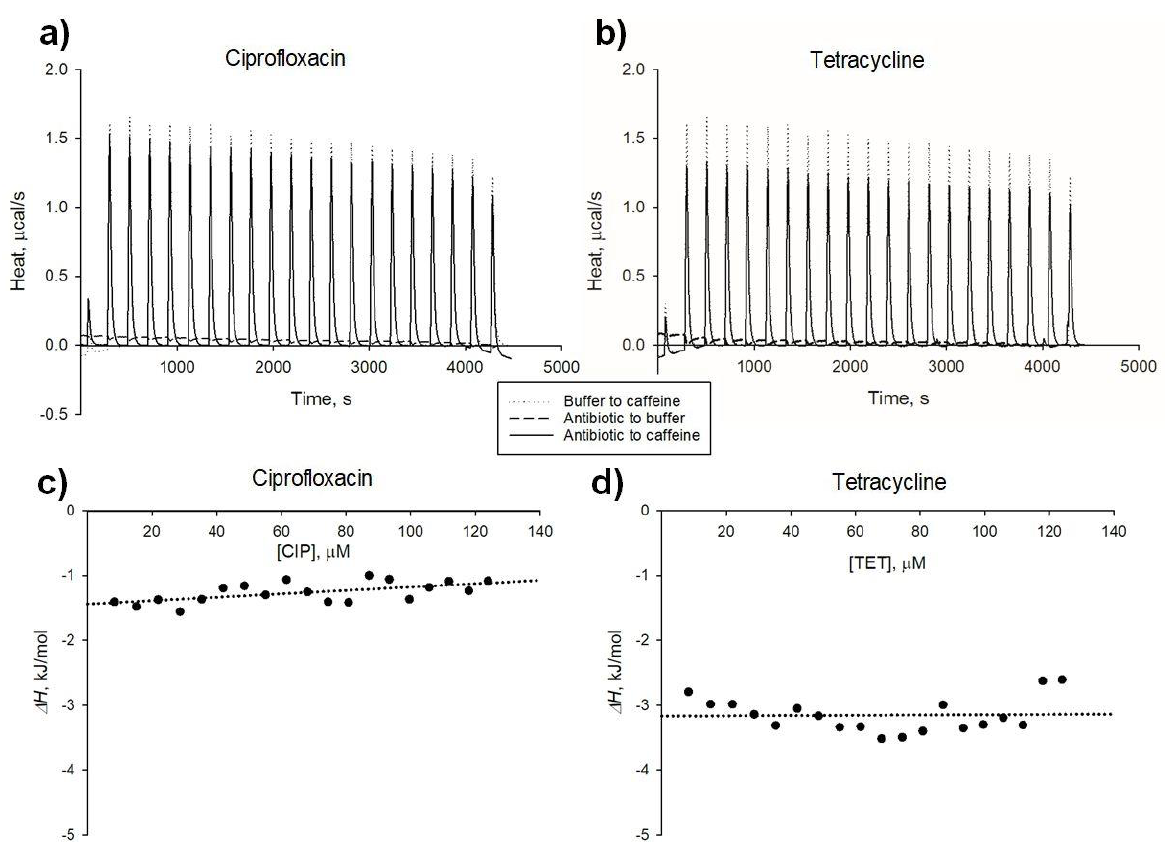
Figure 4. Thermal effects of antibiotic-caffeine complex formation—analysis with isothermal titration calorimetry. ( a,b ), thermograms for analysis of ciprofloxacin-caffeine ( a ) and tetracycline-caffeine ( b ) interactions; solid line, titration of caffeine with antibiotic; dotted line, titration of caffeine with buffer; dashed line, titration of buffer with antibiotic; ( c,d ), determination of enthalpy change (Δ H ) values for ciprofloxacin-caffeine ( c ) and tetracycline-caffeine ( d ) interactions. Points correspond to net heat of antibiotic-xanthine interaction (corrected for heats of buffer-to-xanthine and antibiotic-to-buffer titrations, see Figure S1) per mole of titrant added. CIP, ciprofloxacin. TET, tetracycline .